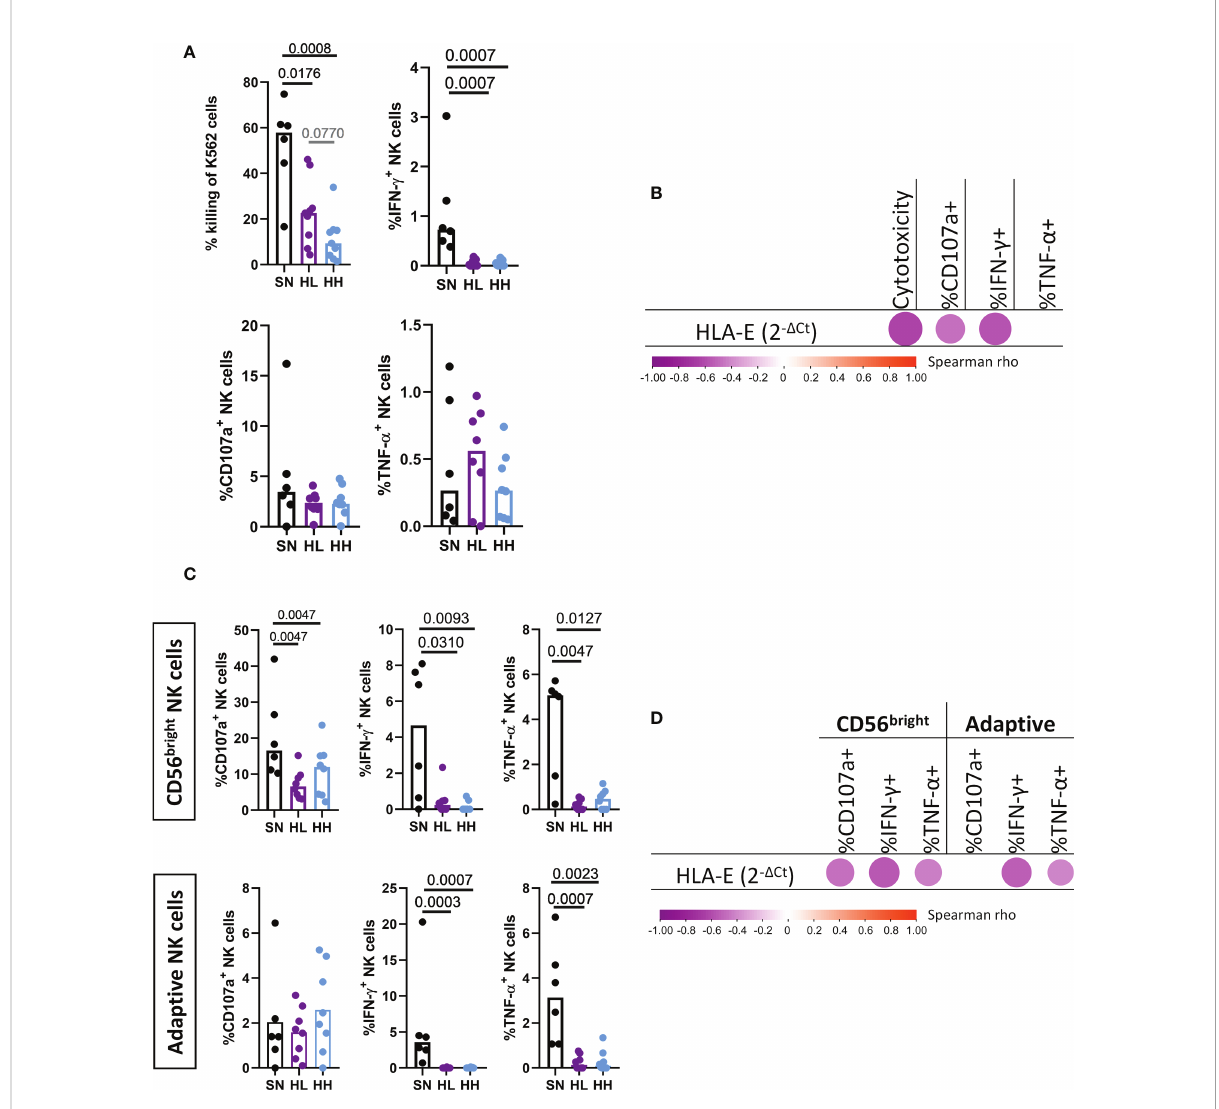
FIGURE 4 Analysis of NK cell cytotoxic activity, degranulation and cytokine secretion upon HLA-E stimulation. Magnetically sorted NK cells from HIV seronegative (SN, black, n=6), HIV-Low (HL, purple, n=8) and HIV-high (HH, blue, n=8) were cocultured with K562 cell lines (lacking the expression of HLA-E) at an effector:target ratio of 5:1. After four hours, NK functional responses were measured by fl ow cytometry. (A) Total NK cell functions: cytotoxicity against K562 (top left), degranulation measured as % of CD107a + (bottom left), production of IFN- g (top right) and TNF- a (bottom right). (B) Correlogram of HLA-E expression in SN, HL and HH with markers of total NK functionality. C ) Functional response in the CD56 bright (top) and adaptive NK cells (bottom) in terms of degranulation (% of CD107a + ) (left), production of IFN- g (middle) and TNF- a (right). (D) Correlogram of HLA-E level of expression with CD56 bright and adaptive NK cell functions. Comparisons between groups were evaluated by Mann-Whitney test for non-parametric data while correlations were performed by Spearman ’ s rank correlation test. Results were considered statistically signi fi cant when p-value <0.05 while trends are shown in